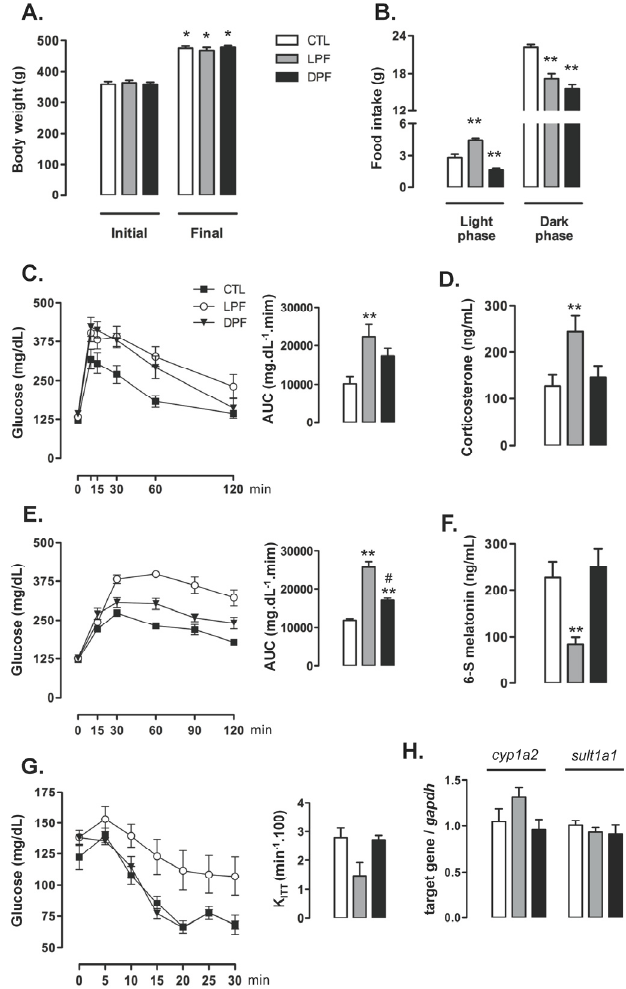
Figure 1. Metabolic and endocrine changes in rats exposed to fructose consumption during the light or the dark phases. Rats assigned to the groups control (CTL), Light Phase Fructose (LPF) and Dark Phase Fructose (DPF) had their ( A ) body weights assessed before and after (8 weeks) treatments. ( B ) Food intake during the light and the dark phases were also assessed at the end of the treatments. After these measurements, the rats were subjected to ( C ) glucose tolerance tests, ( E ) pyruvate tolerance tests and ( G ) insulin tolerance tests. Tests were performed two hours before “lights off” and the area under the curve (AUC) was calculated. Euthanasia was performed two hours before “lights off” when fragments of liver and plasma were collected. ( D ) Plasma samples were used for the determination of corticosterone levels. ( F ) Urine was collected overnight before euthanasia for determination of 6 ‐ S ‐ Mel concentration. Fragments of liver were used for relative determination of ( H ) cyp1a2 and sult1a1 mRNAs by real time PCR. The results are presented as the means ± standard error of the mean. * p < 0.05 vs. the same group before treatment; ** p < 0.05 vs. CTL at the same phase of the light/dark cycle; # p < 0.05 vs. LPF at the same phase of the light/dark cycle.